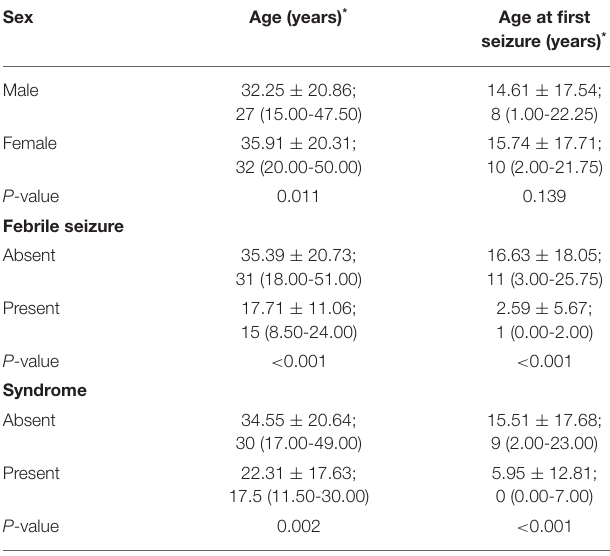
TABLE 3 | Clinical data in association with age and age at the first seizure in patients with epilepsy from a Brazilian University Hospital in Southeast São Paulo between January 2010 and March